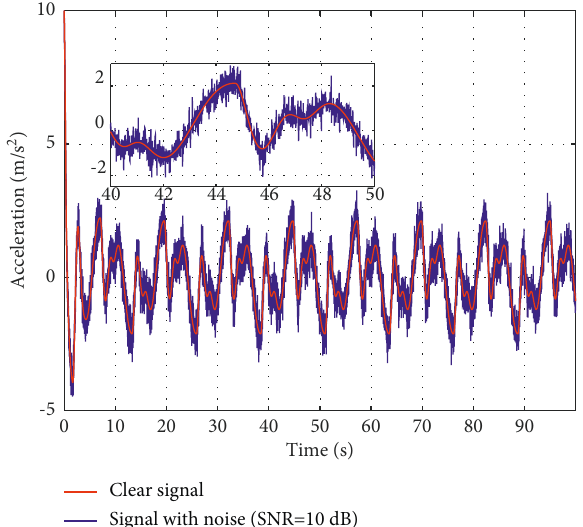
Figure 9: Comparison of clear and contaminated acceleration signals of hysteretic